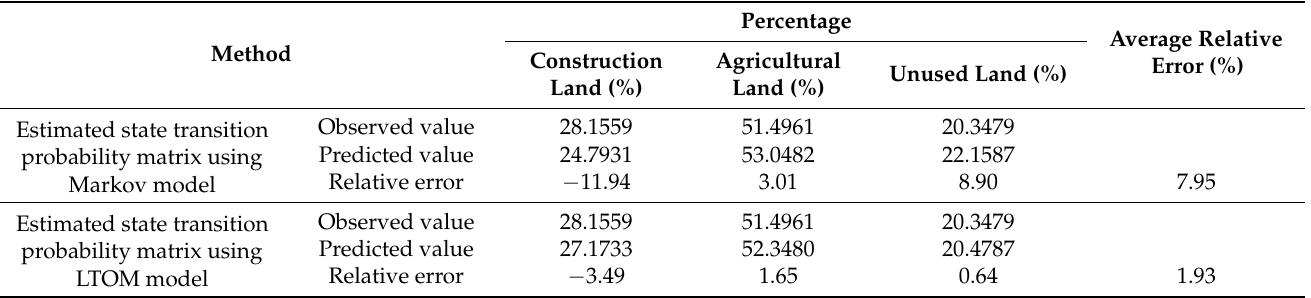
Table 2. Prediction results and accuracy of the area percentage of three types of land use in Nansha District in 2020 with 2019 as the base period (1-year interval).